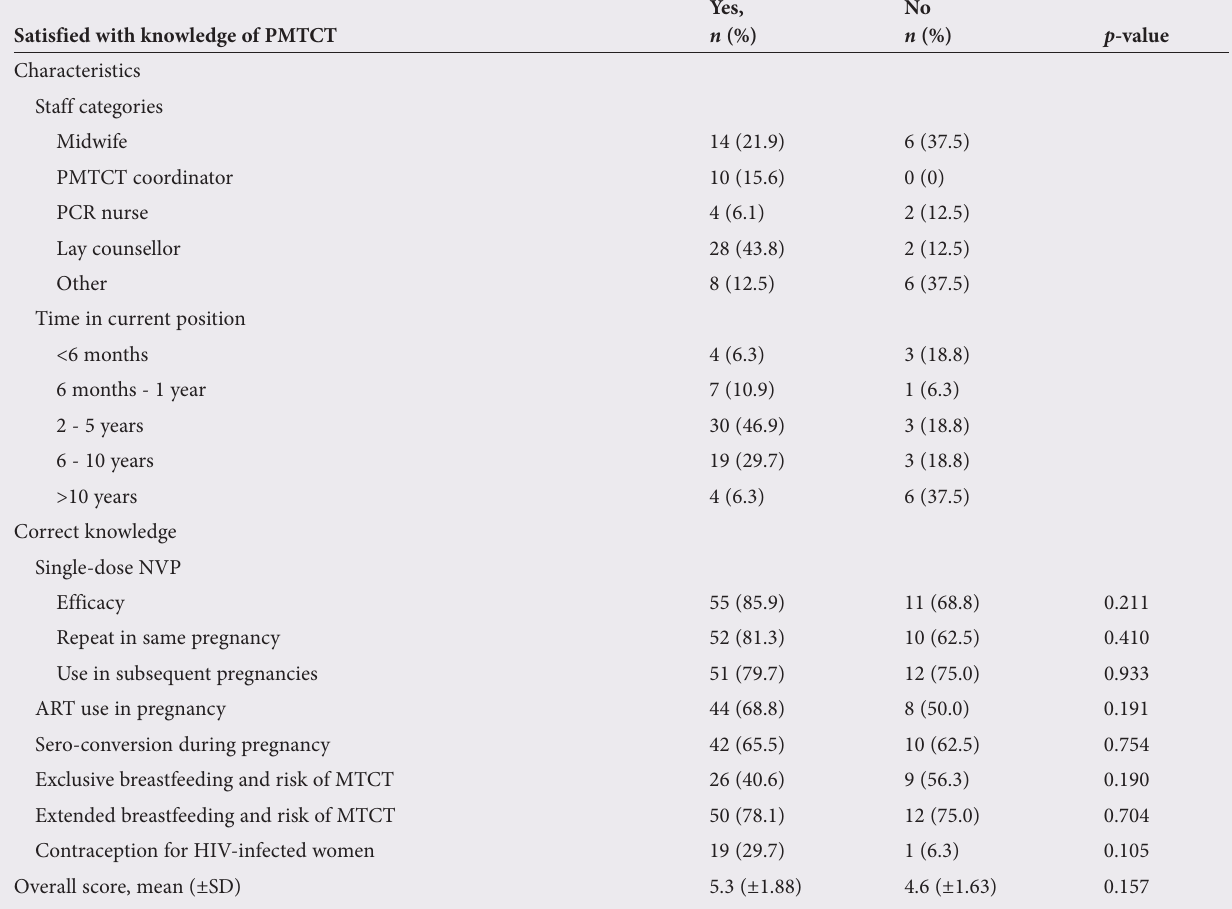
Table 5. Characteristics and knowledge of healthcare workers who were satisfied with their knowledge of PMTCT ( N =64) v. those who were not ( N =16) Satisfied with knowledge of